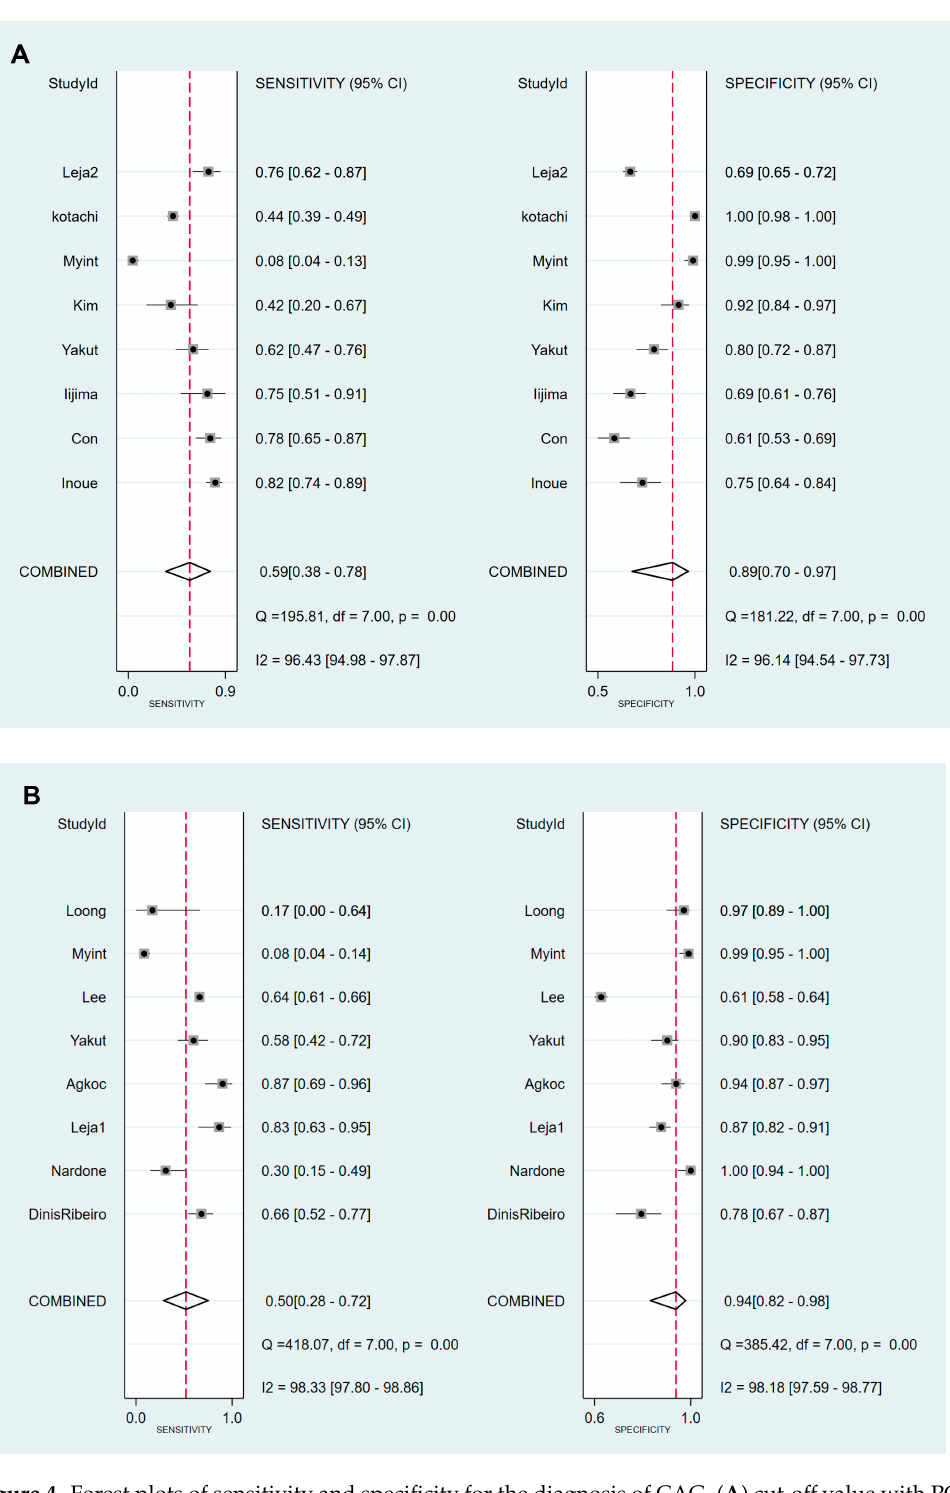
Figure 4. Forest plots of sensitivity and specificity for the diagnosis of CAG. ( A ) cut-off value with PG I ≤ 70 ng/mL and PG I/PG II ratio ≤ 3, ( B ) cut-off value with PG I/PG II ratio ≤ 3. CAG, chronic atrophic gastritis; PG, pepsinogen.